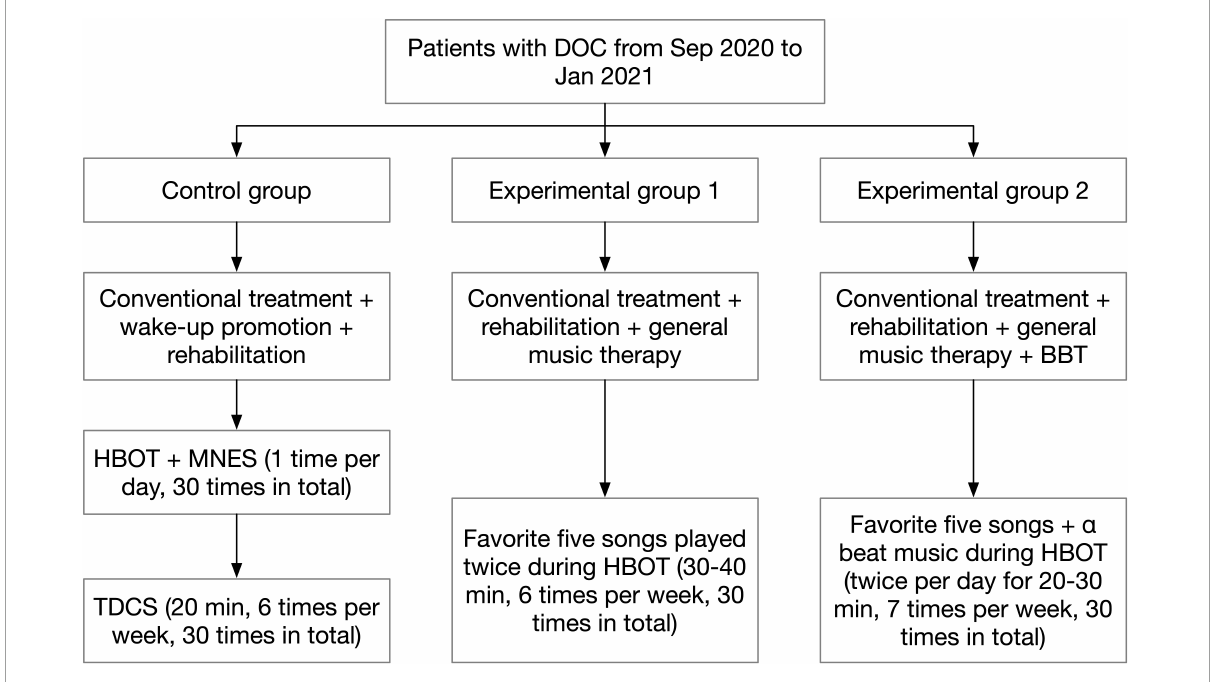
FIGURE1 Flow diagram of group assignment. BBT, binaural beat therapy; DOC, disturbance of consciousness; HBOT, hyperbaric oxygen therapy; MNES, median nerve stimulation; TDCS, transcranial direct current stimulation.